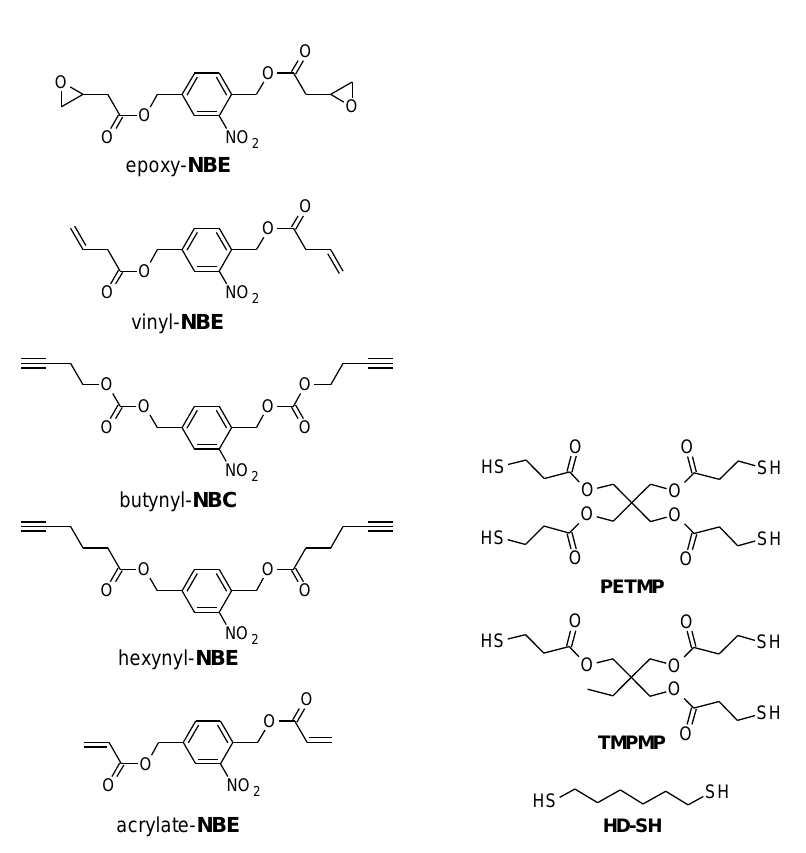
Figure 9. Monomers used for the preparation of the different photo-responsive thiol-click formulations.